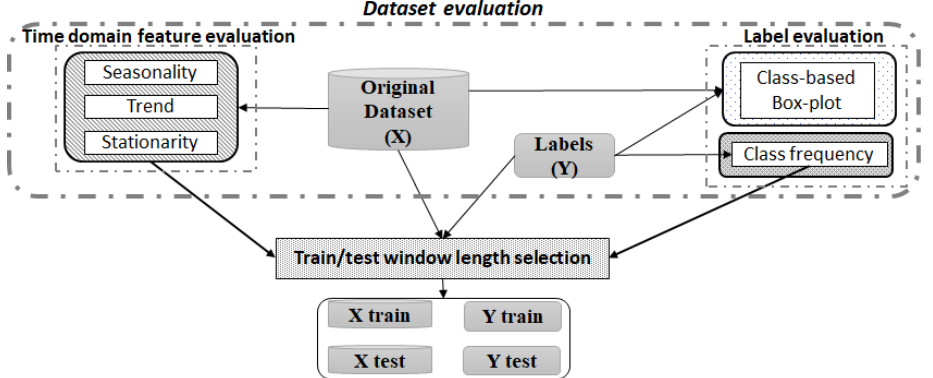
Figure 2. Dataset evaluation